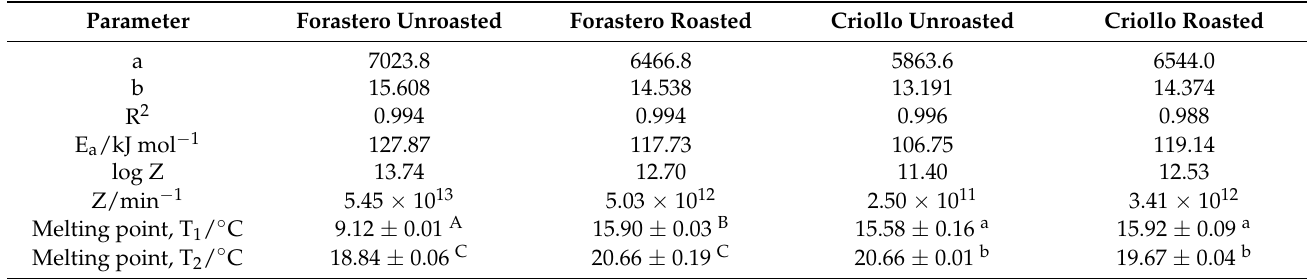
Melting point, T 1 / ◦ C Melting point, T 2 / ◦ C Values represent means ± standard deviations. Means with equal superscripts in each group for the same column are not significantly different ( p > 0.05) by Tukey’s test. The different lower-case letters (a–b) indicate significantly different values for Forastero beans ( p < 0.05). The different capital letters (A–C) indicate significantly different values for Criollo beans ( p < 0.05). For the fat extracted from Criollo species, the values of activation energy reached 106.75 and 119.14 kJ mol − 1 , for unroasted and roasted cocoa beans, respectively. For